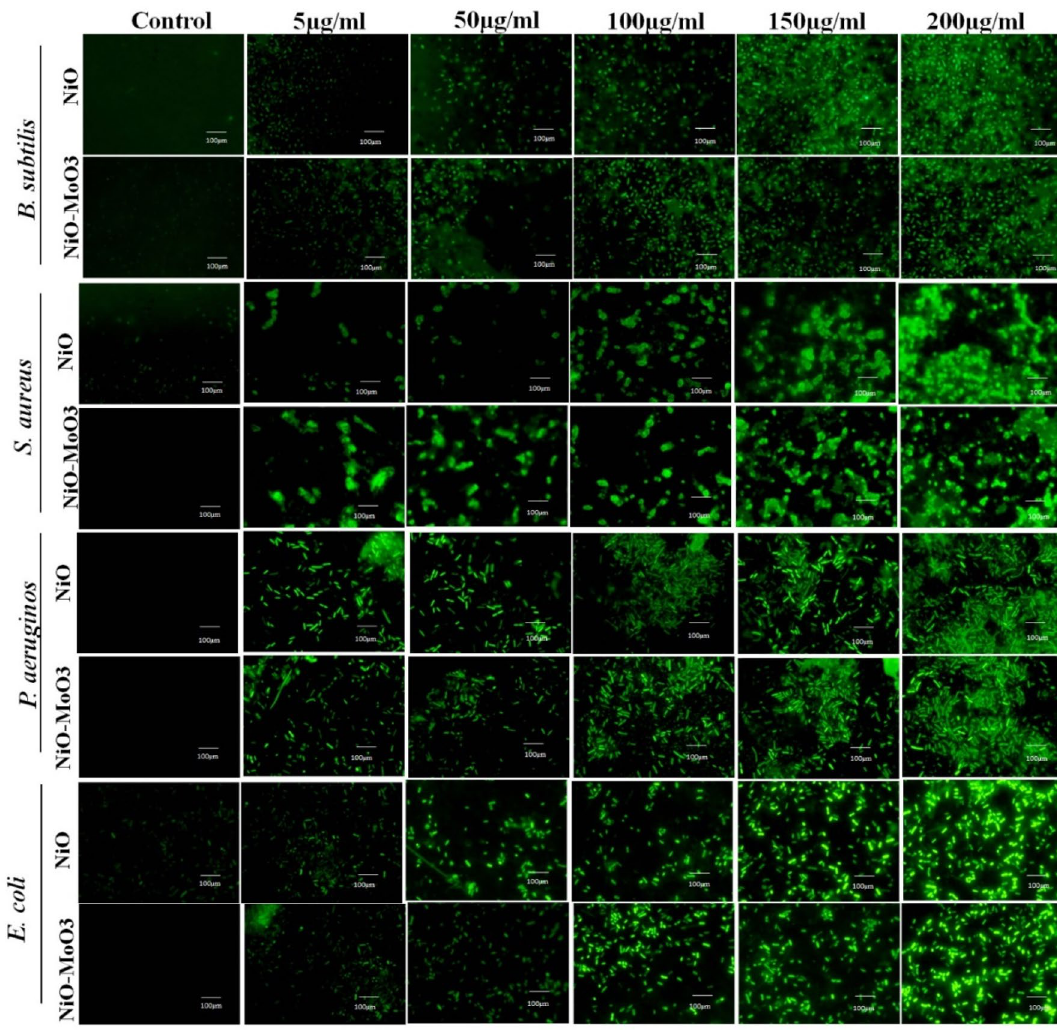
Figure 10. The NiO NPs and Mo doped NiO NPs induced ROS production in bacterial cells B. subtilis , S. aureus gram-positive P. aeruginosa , and E. coli in a concentration dependent